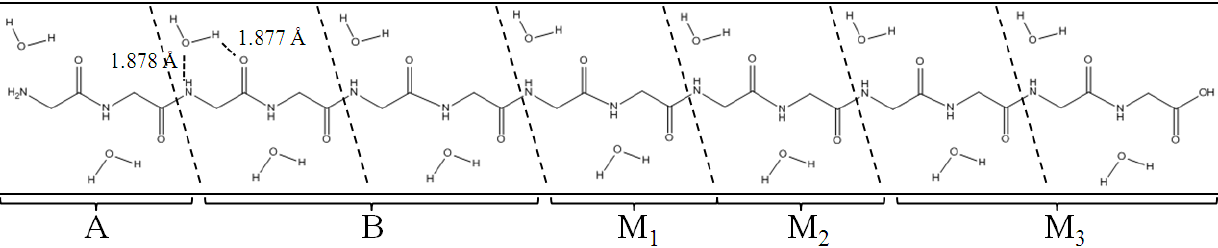
Figure 3. Polyglycine (Gly) are divided into A, B, M A and B do not correspond to those in Figure